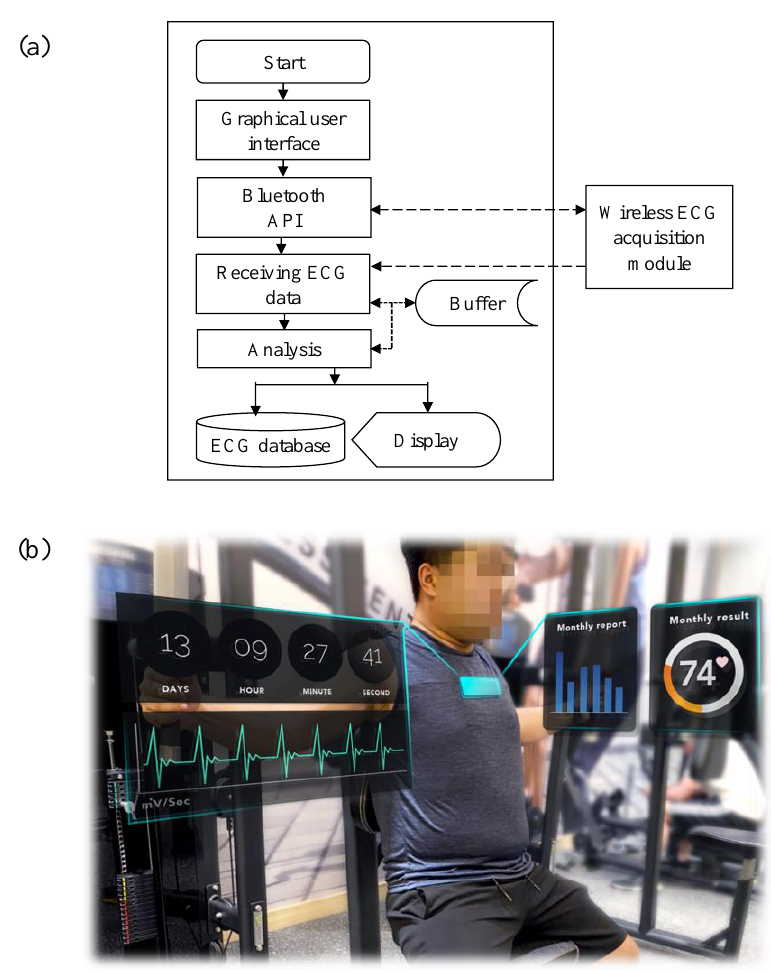
Figure 6. ( a ) Flowchart of proposed ECG monitoring program and ( b ) scenario diagram of the proposed smart clothes system.